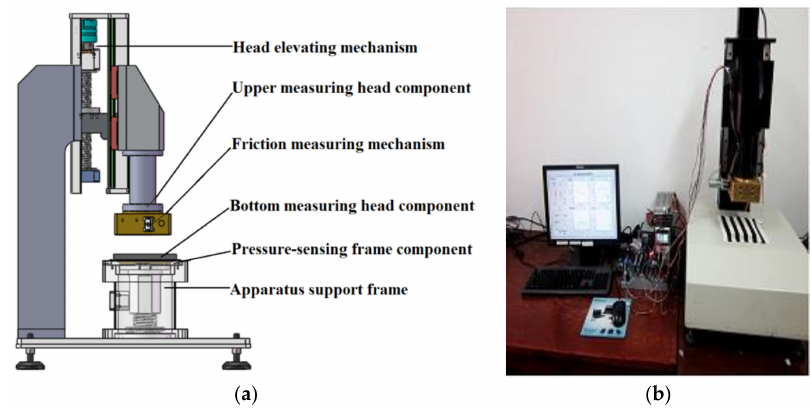
Figure 1. Mechanical device of the measurement system: ( a ) structural diagram; ( b ) prototype of the mechanical device.